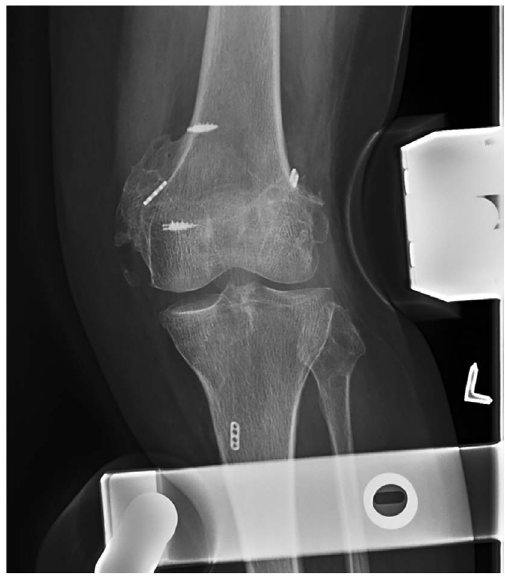
Figure 5. Radiographic valgus stress view of a patient with a KDIIIM, showing heterotopic ossi fi cation around the medial epicondyle at 9 months postoperatively.